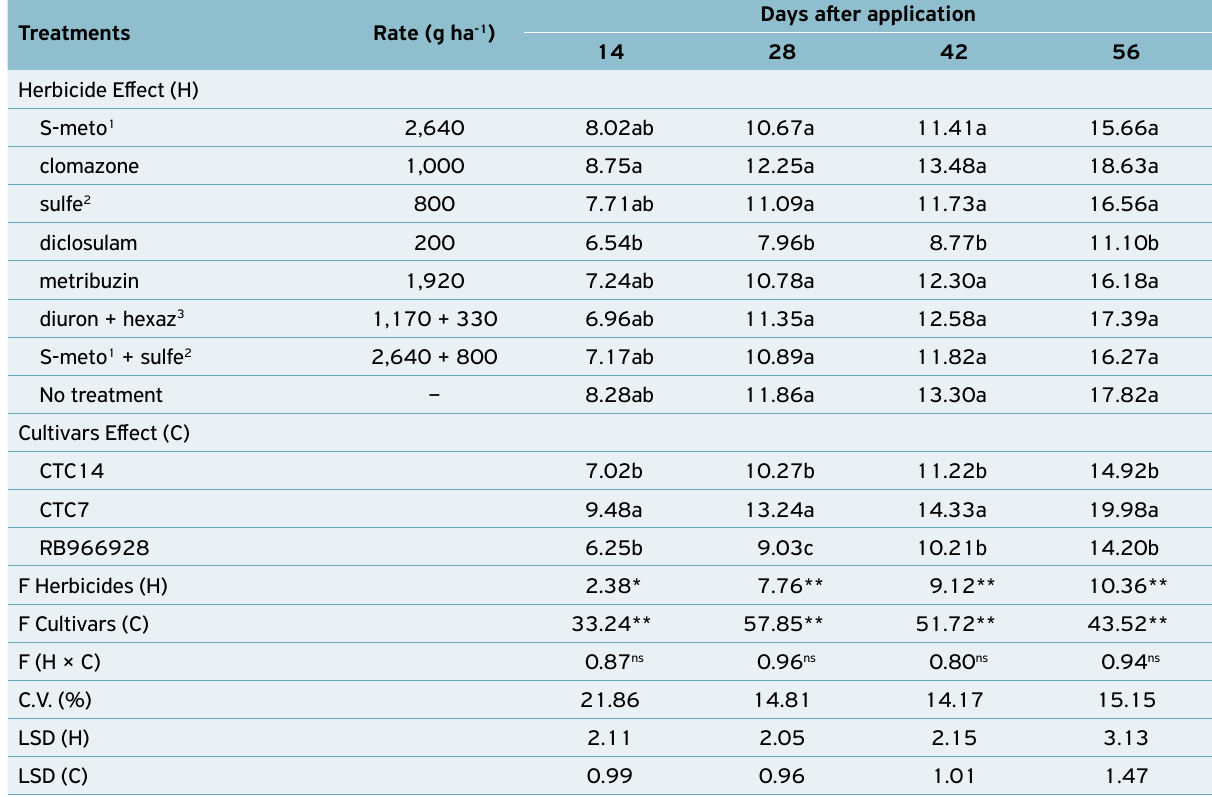
Table 3. Mean values of height (cm) caused by different herbicides applied in pre-planting to three sugar cane cultivars. Pradópolis, state of São Paulo, Brazil,